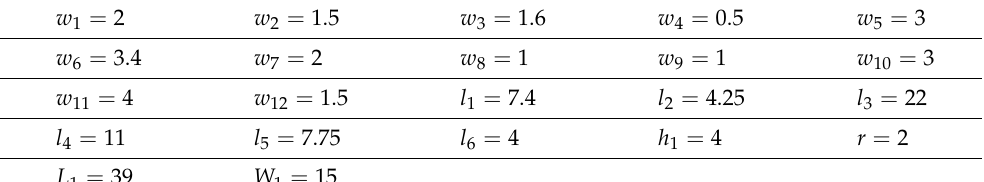
Table 1. Design parameters of the dual-band antenna (Ant#2). All dimensions are in millimeters. w 1 = 2 w 2 =